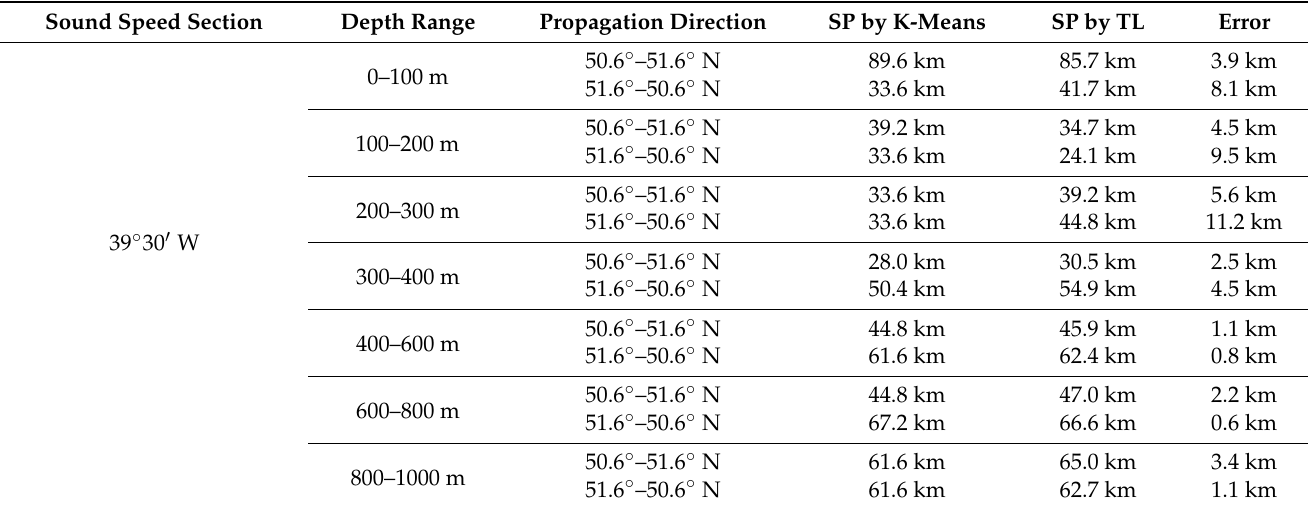
Table 1. The comparison of the accuracy of the K-means algorithms on the identification of the frontal zone in different depth ranges at 39 ◦ 30 (cid:48) W section (SP by K-means means the starting point of the frontal zone obtained by K-means, SP by TL means the starting point of the frontal zone obtained by calculating the TL, Error means the difference between SP by K-means and SP by TL).